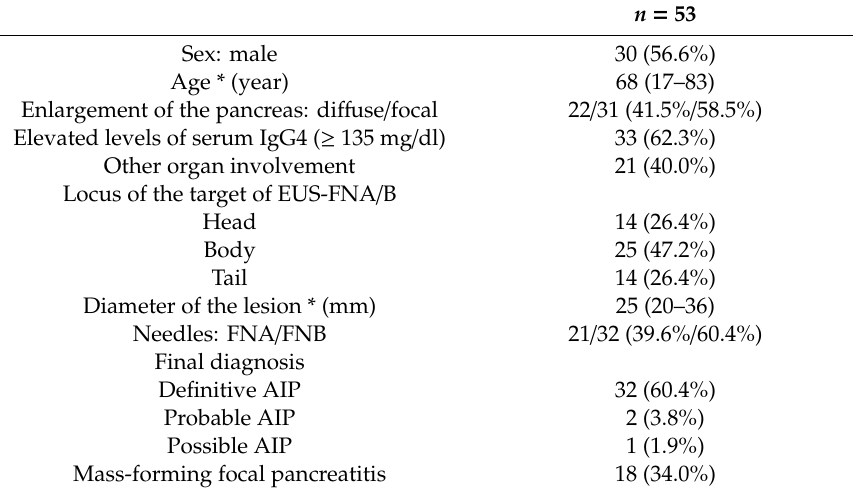
Table 1. Patients characteristics and final